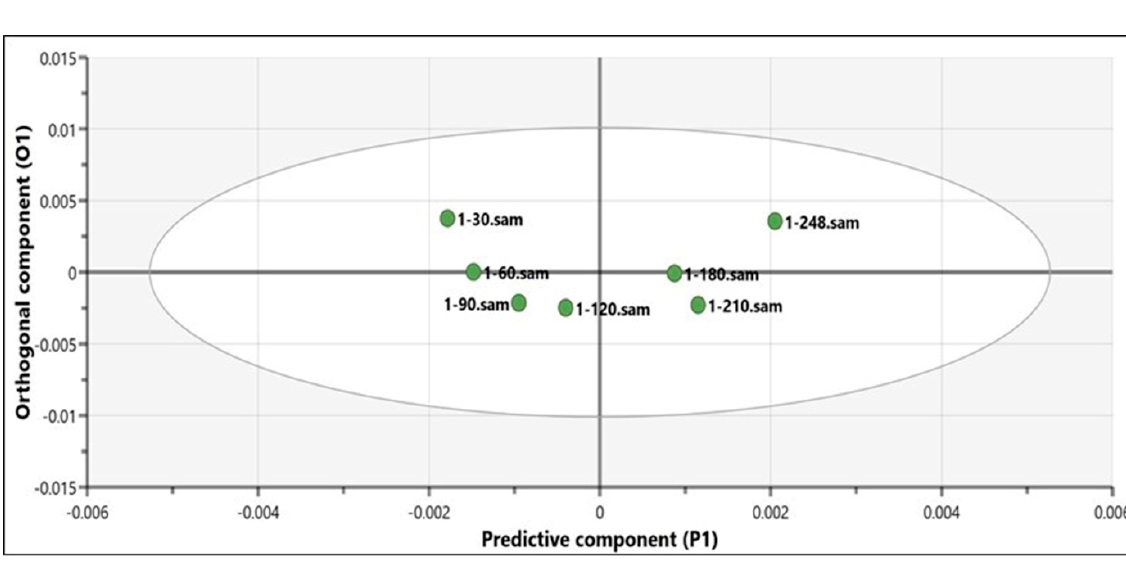
Figure 3. Scores scatter plot obtained from the orthogonal partial least squares (OPLS) analysis of the spectra corresponding to the 8 dry extract samples.